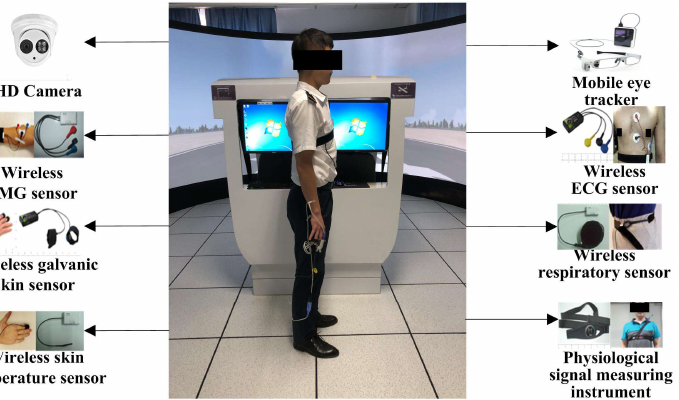
Figure 2. Comprehensive information acquisition experimental platform for human–aircraft–envi-